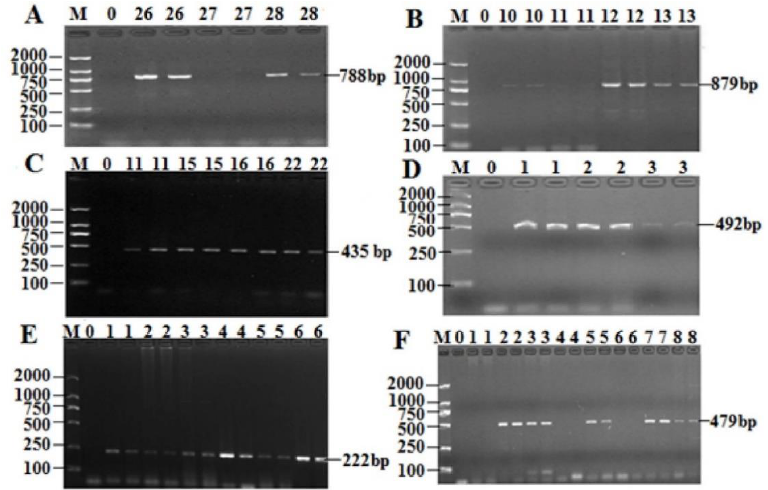
Figure 5. PCR detection results of some T. halophilus resistance genes. ( A ) blaTEM gene; ( B ) GyrB gene; ( C ) SulII gene; ( D ) EmgrB gene; ( E ) acrB gene; ( F ) aadA1 gene; M: DL2000Marker, 0: Negative control.